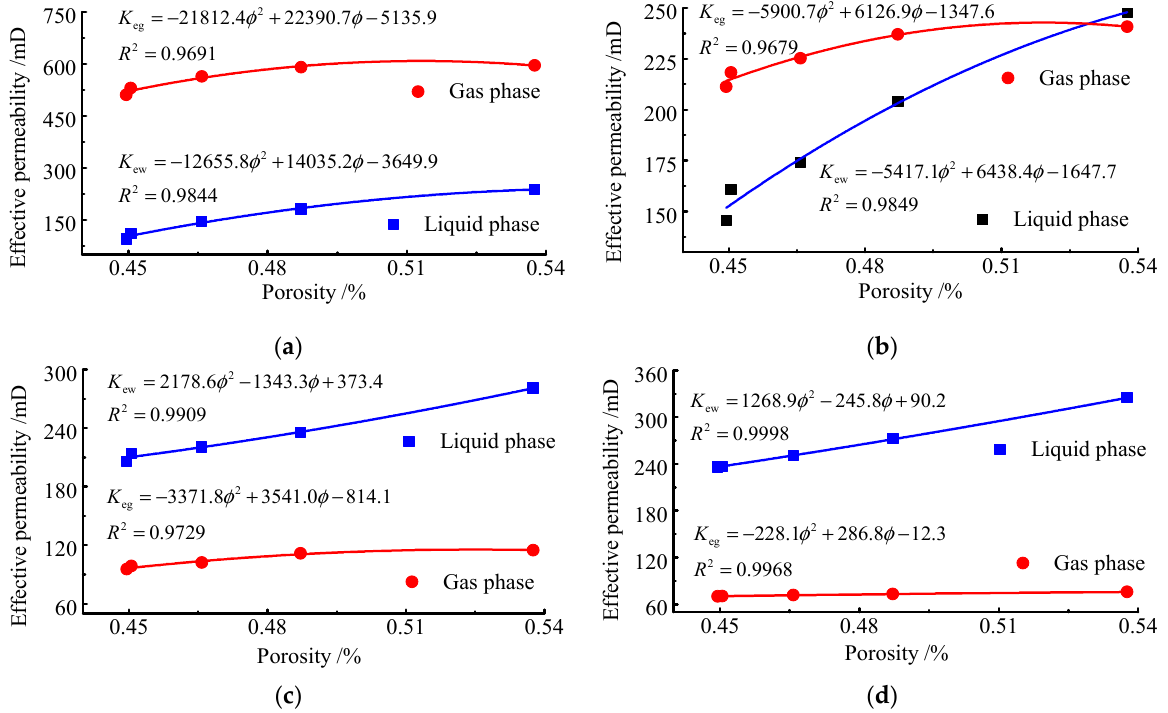
Figure 6. Effect of porosity on effective permeability. ( a ) p = 0.2 MPa; ( b ) p = 0.4 MPa; ( c ) p = 0.6 MPa; ( d ) p = 0.8 MPa.